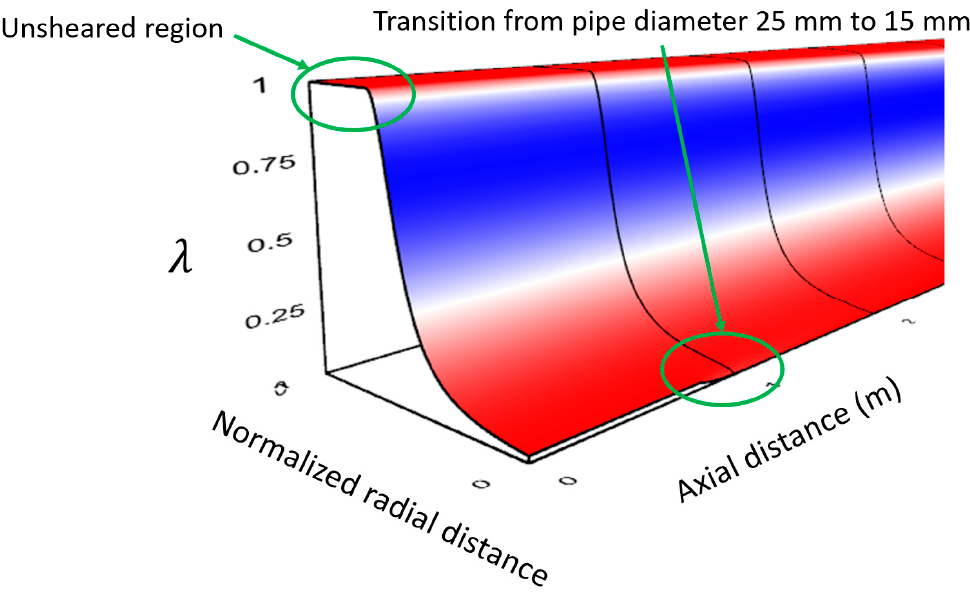
Figure 18. Representation of the structure parameter as a function of the normalized radial position and axial distance after the pressure relief valve. The color scale is gradient based.